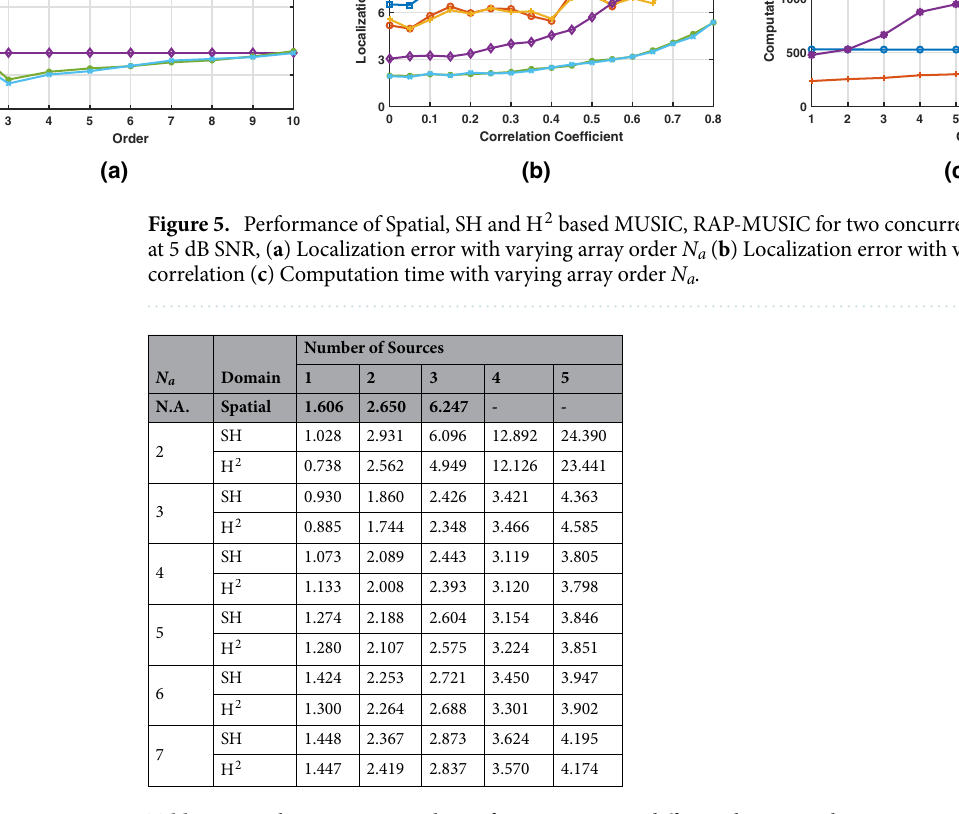
Table 2. Localization error analysis of RAP-MUSIC in different domain with varying number of